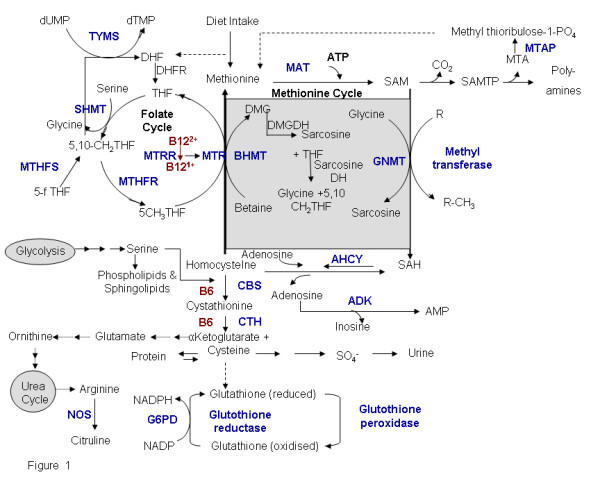
Methionine-Homocysteine metabolism and related pathways. A representation of the methionine cycle (central), transulfuration pathway and its connection to folate cycle, glycolysis pathway and urea cycle. The genes marked in blue have been identified by literature based searches as mentioned in the methods section. The solid and dotted lines indicate direct and indirect (multi step) interaction/ conversion respectively.